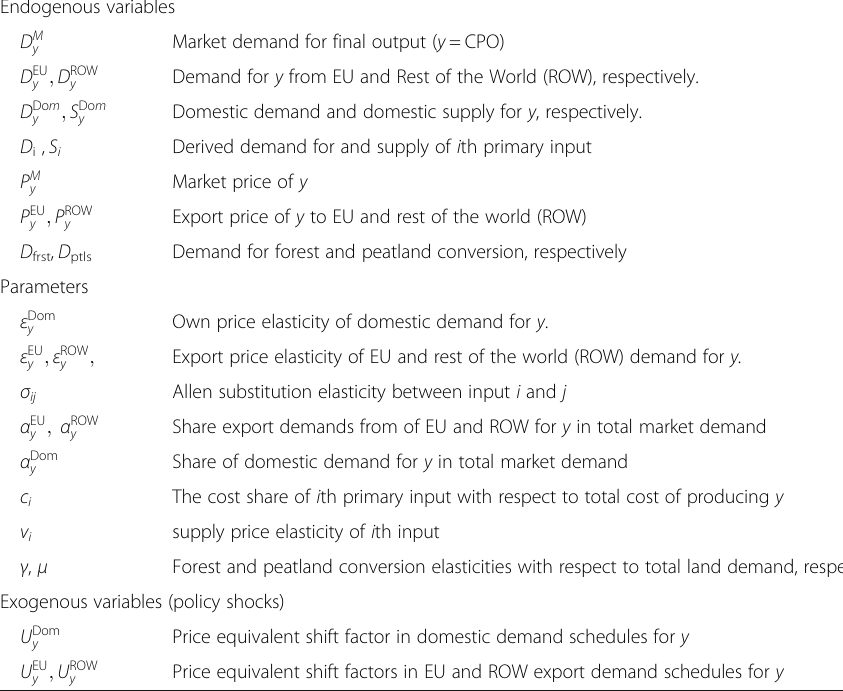
Table 4 Definitions of variables of